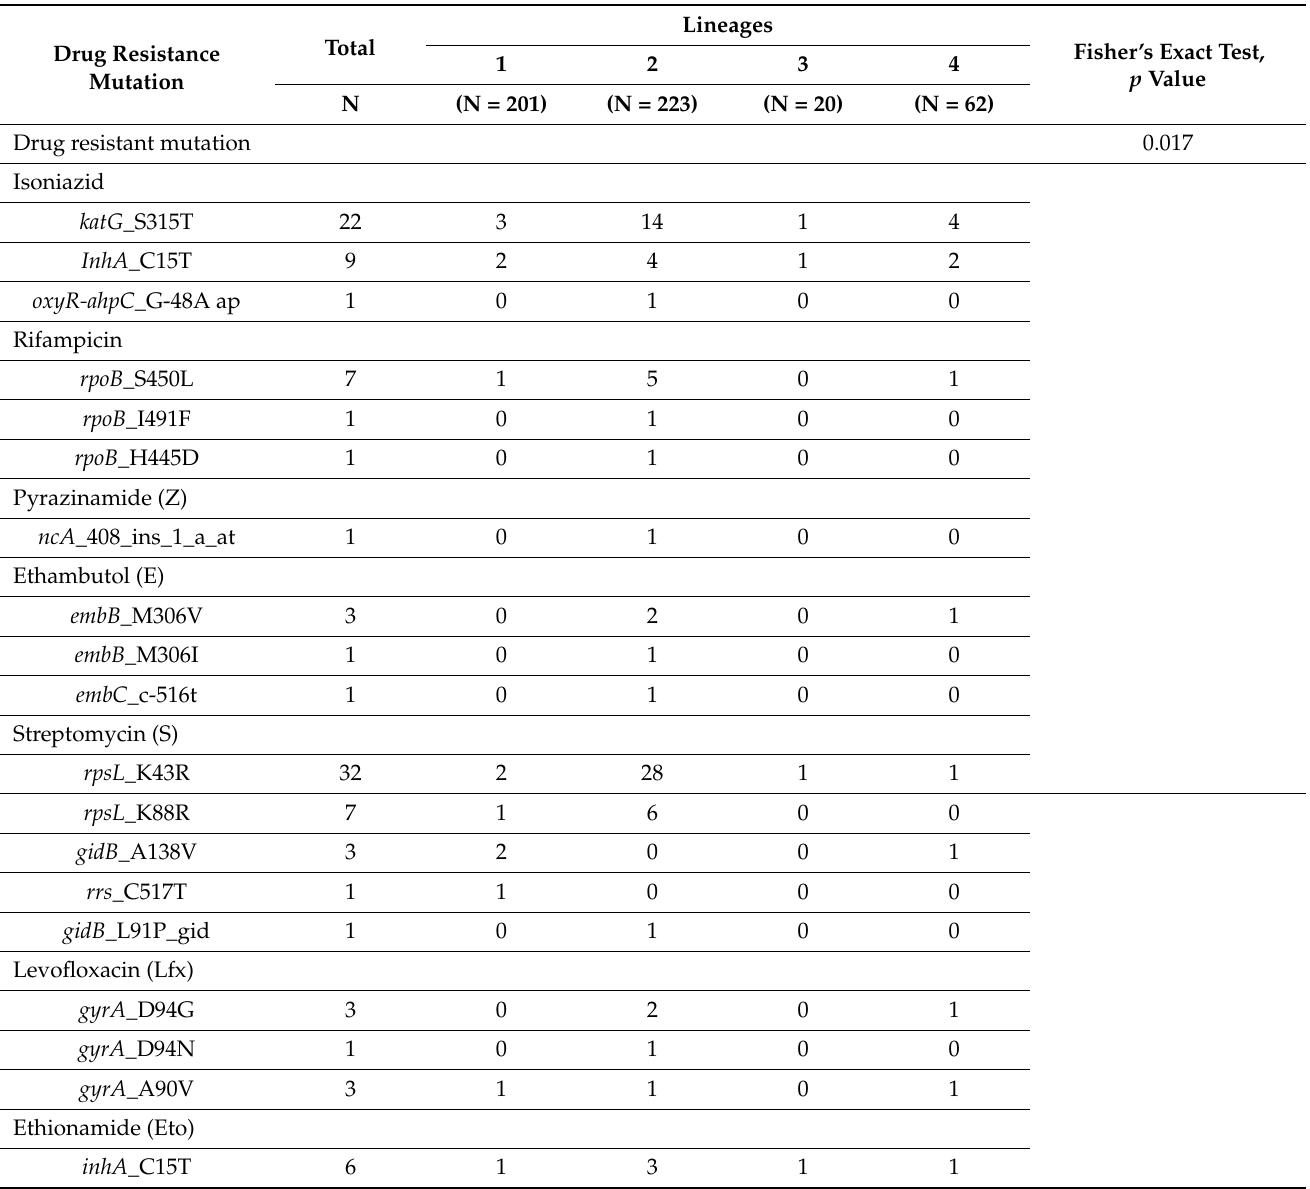
Table 4. Association between lineages and drug resistance